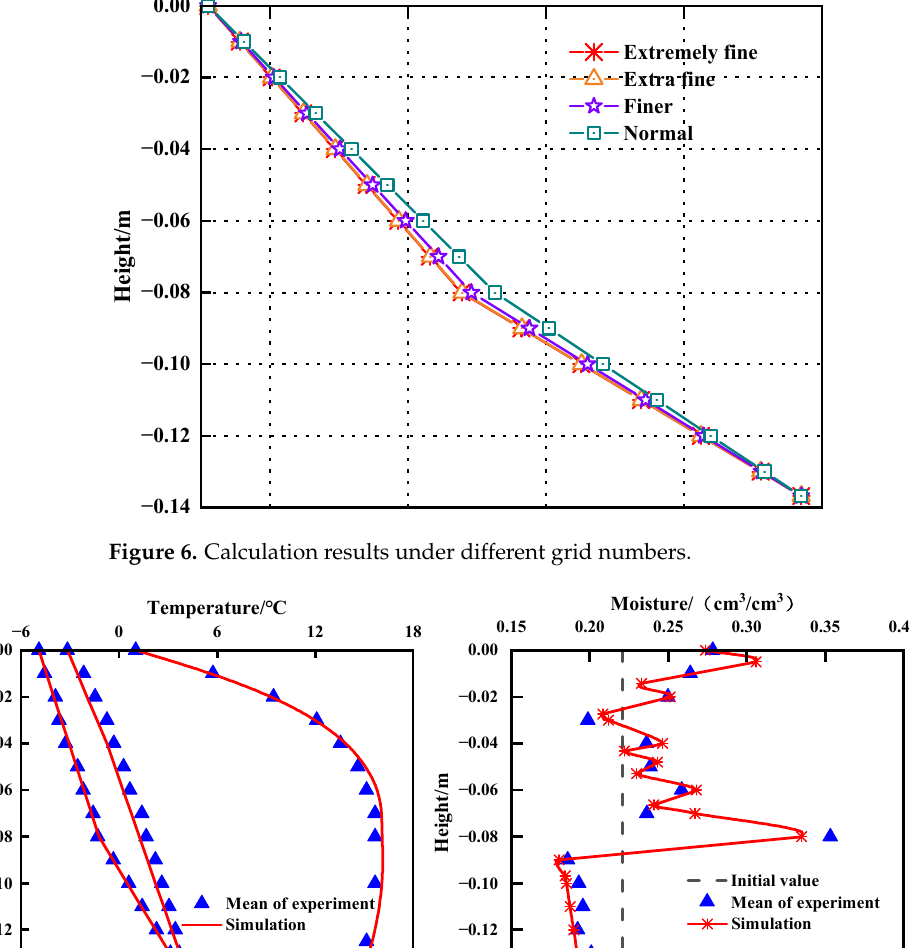
Table 3. Two contrasting models.